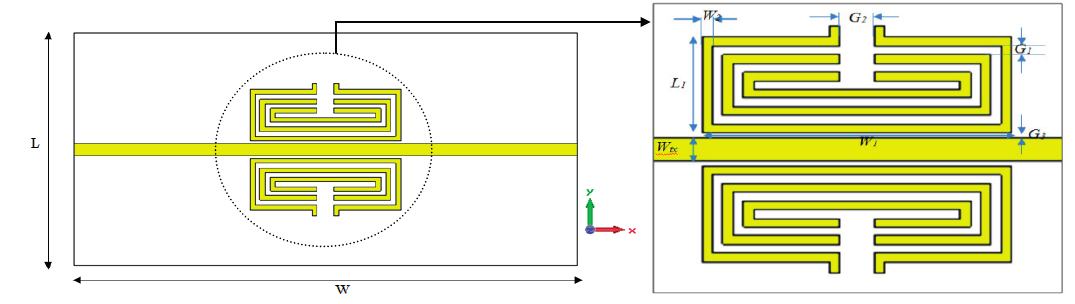
Figure 1. Schematic view of the aligned-gap MSRR structure and its dimensions.